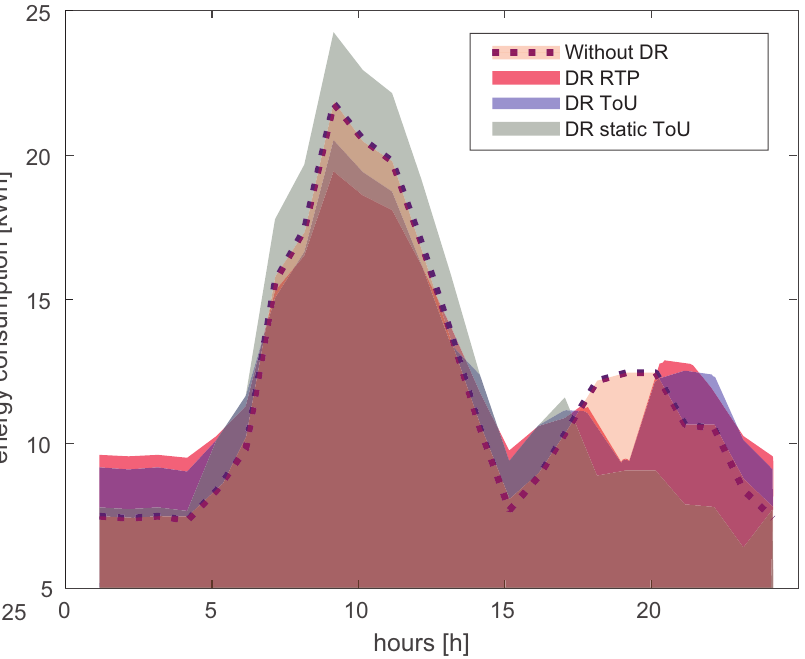
Figure 18. DR Demand variation.